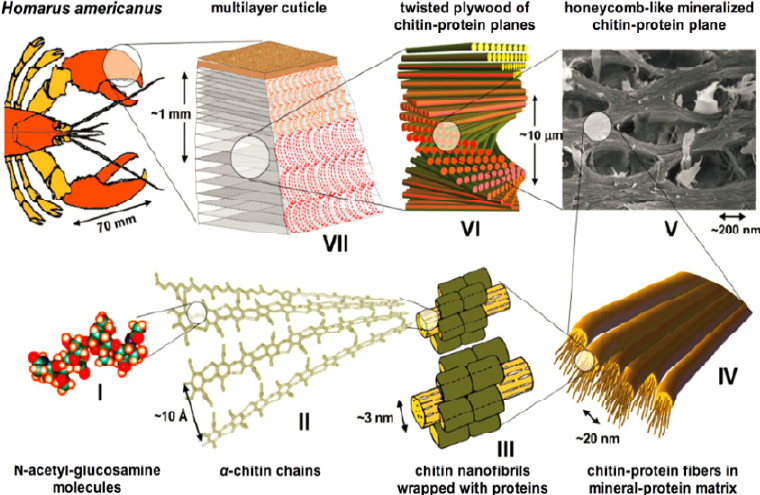
Figure 7. Hierarchical structure of lobster cuticle. Reproduced with permission from